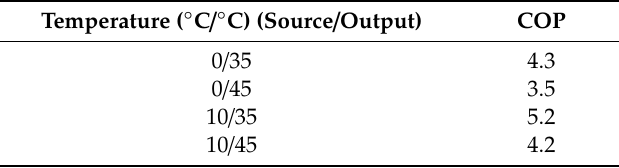
Table 2. COP of the ground-source heat pump [41] at the standardized test conditions [42].